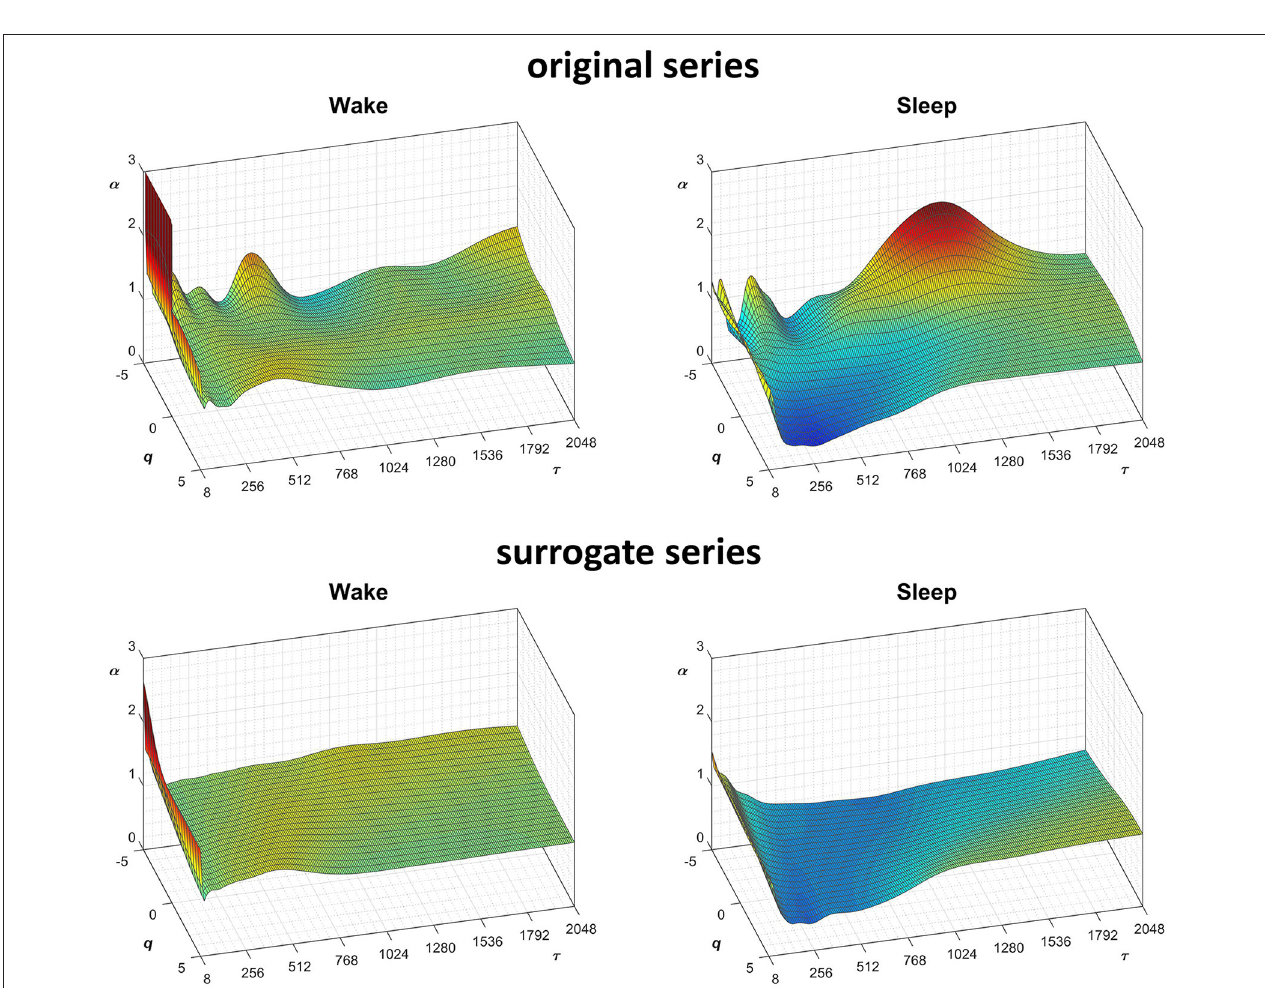
FIGURE 9 | Scale coefficients of heart-rate variability during Wake and Sleep, for original and surrogate series. Coefficients calculated by Equations (22), combining DFA 1 and DFA 2 estimates by Equations (23); for surrogate data, the figure shows the average α surface over 100 series generated shuffling the phases of the Fourier spectrum of the original series. To more easily compare Wake and Sleep conditions, which are characterized by different heart rates, the τ axis represents the temporal scale in seconds; τ is obtained multiplying the box size, n , with the mean R-R interval (see Figure 8 ).